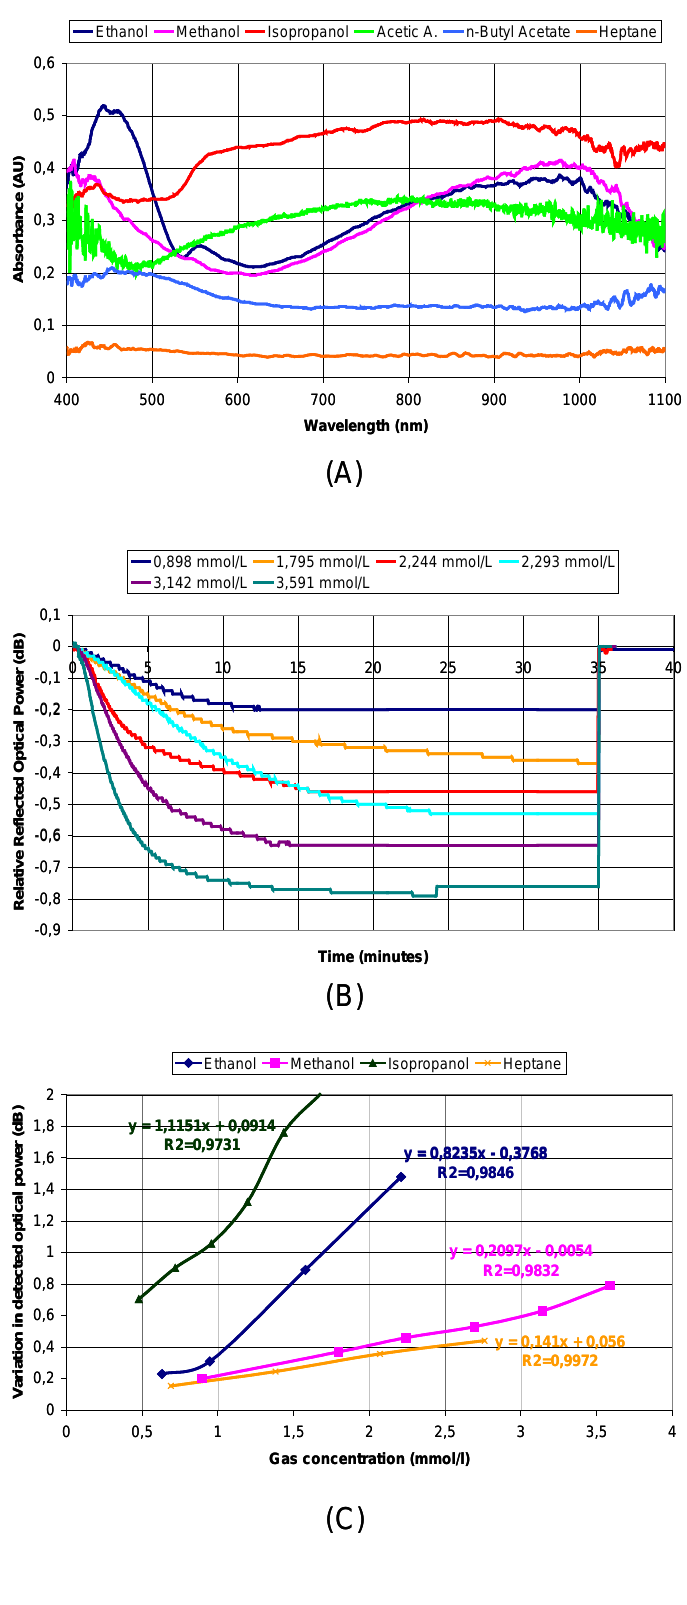
Figure 23 . Characterization of a non selective sensor in terms of: (a) absorbance spectra when exposed to different organic vapors; (b) reflected optical power variation with different methanol concentrations; (c) calibration curves for some VOCs based on (b)